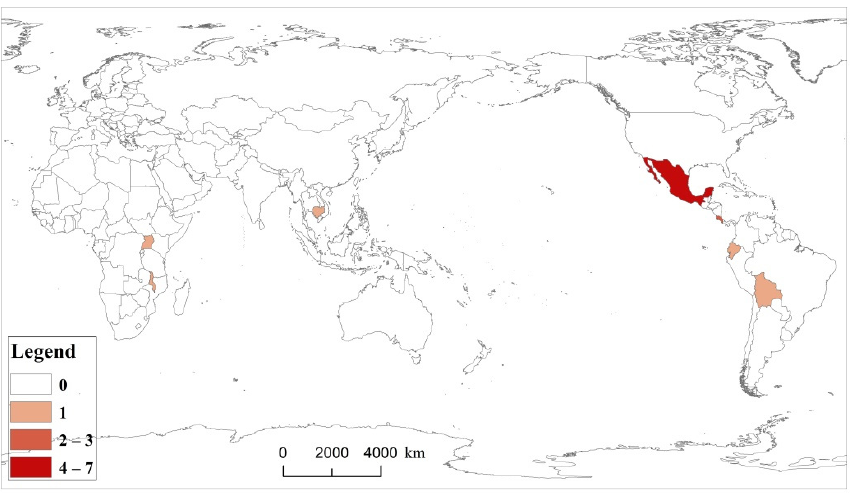
Figure 1. The map of environment effect cases of PES in meta-regression analysis.